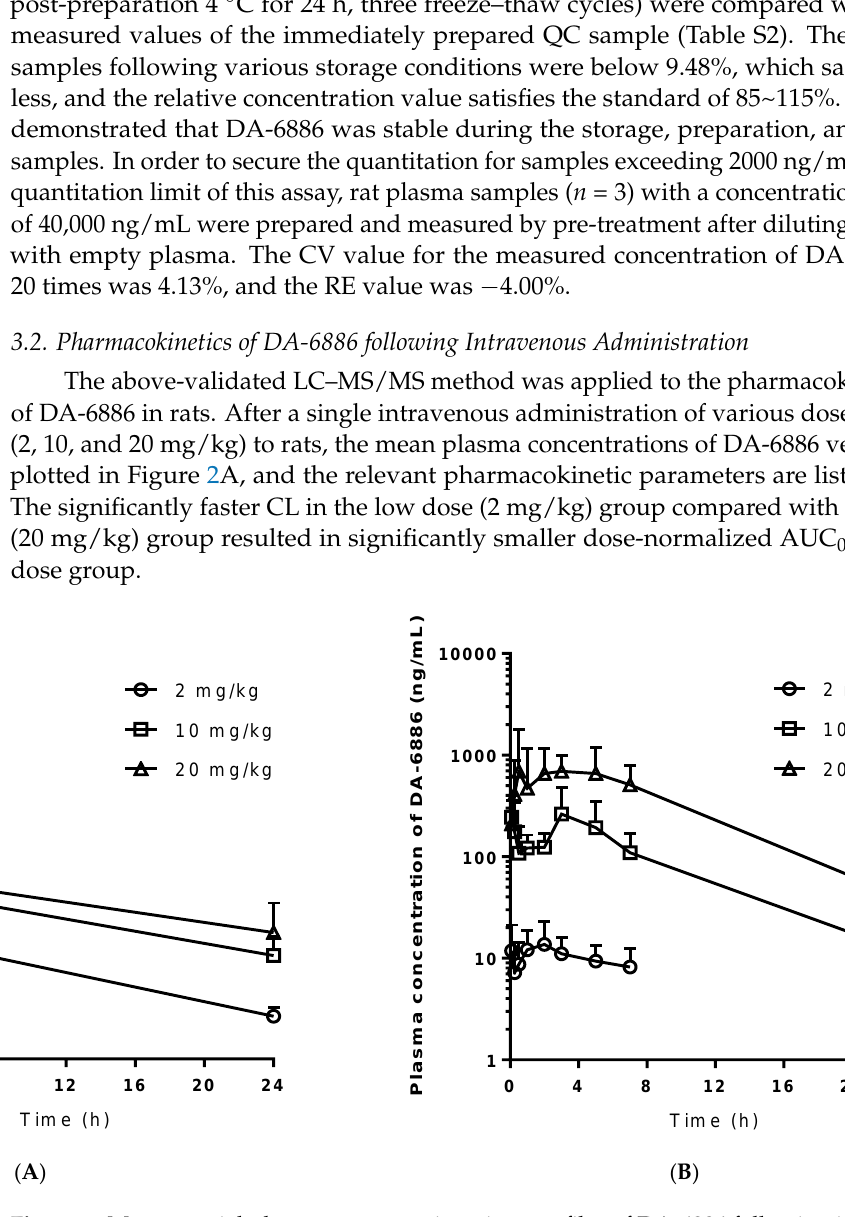
Figure 2. Mean arterial plasma concentration–time profiles of DA-6886 following intravenous ( A ) and oral ( B ) administration of DA-6886 at doses of 2, 10, and 20 mg/kg to rats ( n = 4 each). Data are expressed as mean ± S.D. Table 2. Pharmacokinetic parameters (mean ± S.D.) for DA-6886 after single intravenous admin- istration at doses of 2, 10, and 20 mg/kg to rats.